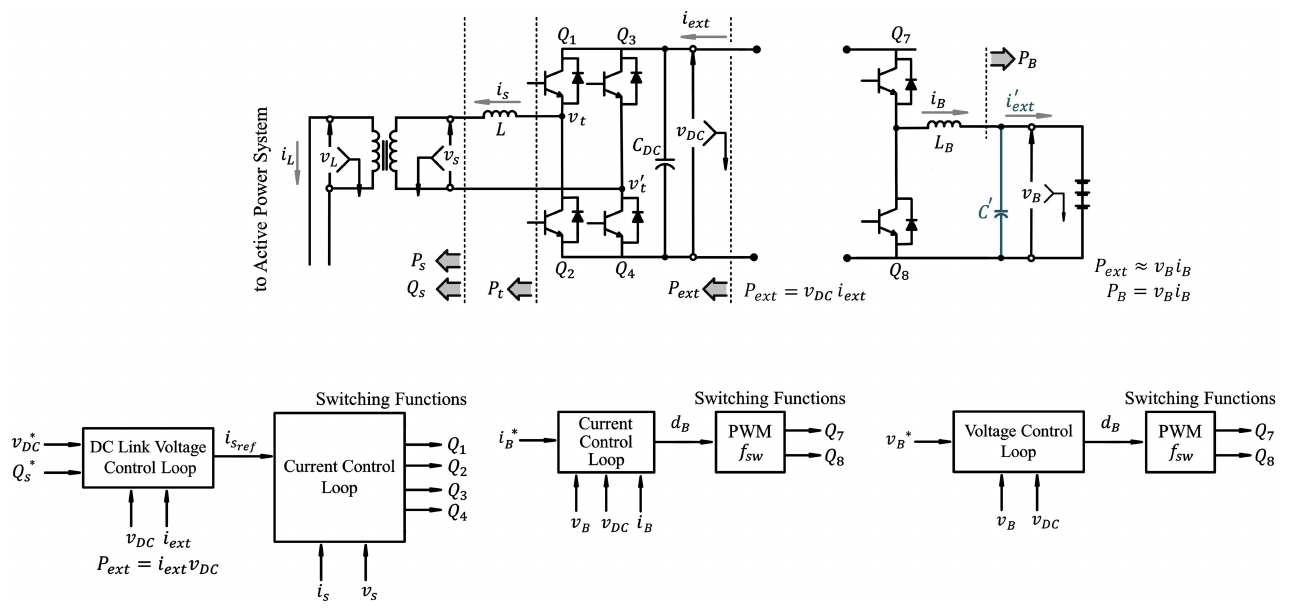
Figure 2. Common single-phase configuration for EV battery chargers with its control